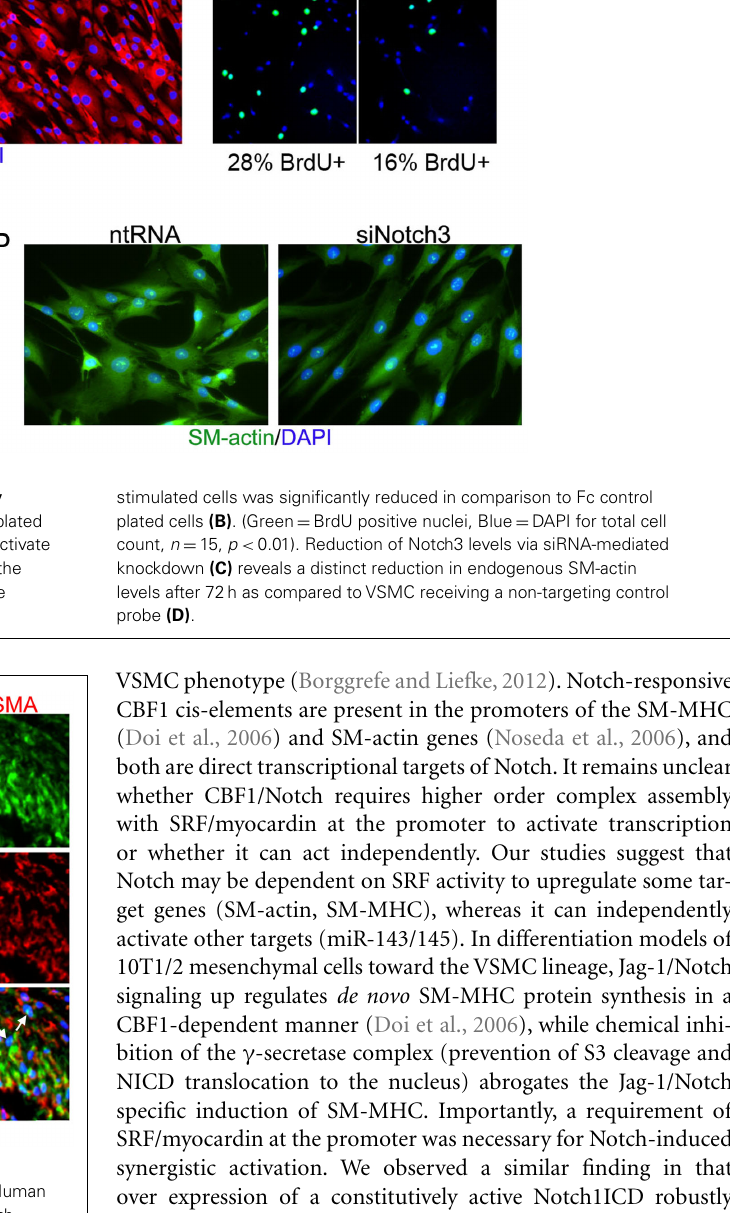
FIGURE 4 | Expression of Notch receptors in human arteries. Human lung biopsies were used for immunohistochemical analysis of Notch receptors expressed by medialVSMC cells. (A) Representative images of Notch receptors (green) and SM-actin positive cells (red) for Notch1 (left), Notch2 (middle), and Notch3 (right). (B) Images were overlaid with DAPI staining to show distribution and localization of Notch receptors within SM-actin positive cells.The elastic laminae display some